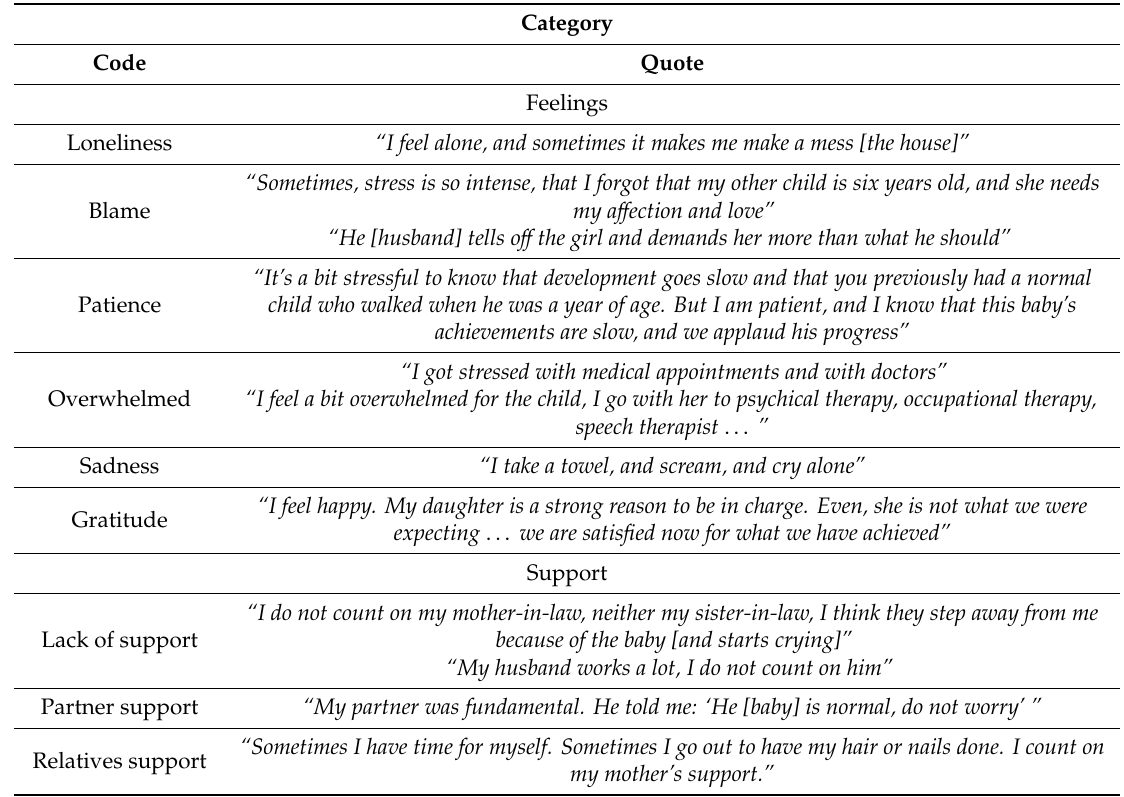
Table 3. The emotional state of mothers carrying microcephalic children.